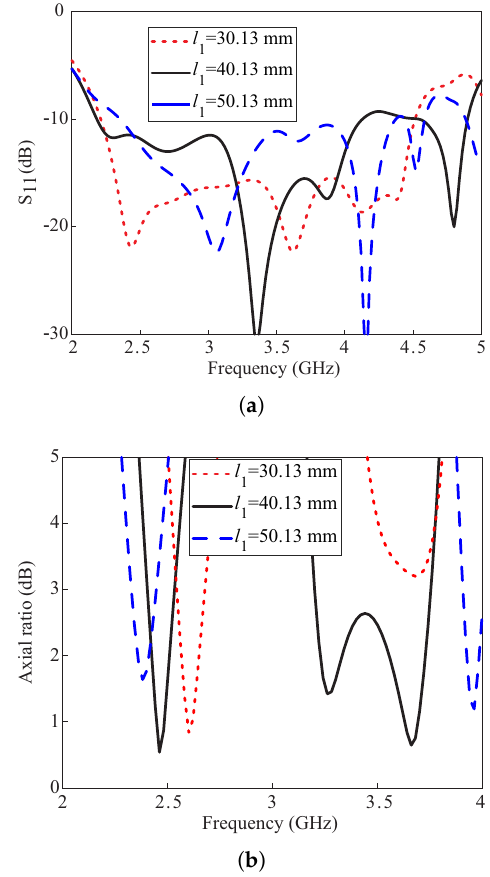
Figure 5. Simulated effects of varying the length l 1 of the DR: ( a ) Reflection coefficients; ( b ) Axial